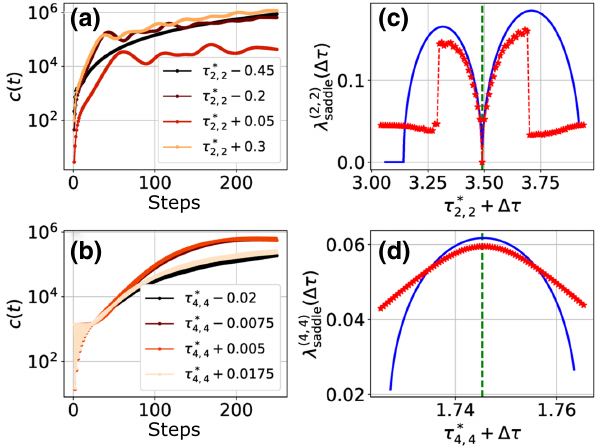
FIG. 4. (a),(b) Examples of time evolution of the out-of-time- order correlation (OTOC) function, c ( t ) , in Eq. (31) for some values of (cid:17)τ inside the structural instability region for the p = 2 and τ ∗ structural instabili- (a) and p = 4 (b), and for the τ ∗ 2,2 4,4 ties, respectively. (c),(d) Exponent of the saddle point controlling the rate of growth of the square commutator at short times. The solid line is the analytical prediction obtained from the classi- cal flow associated with the effective Hamiltonian and the stars plus dashed line are the exponents obtained numerically by lin- ear fit to the section of the data that grows exponentially. For this calculations, we used N = 128, s =